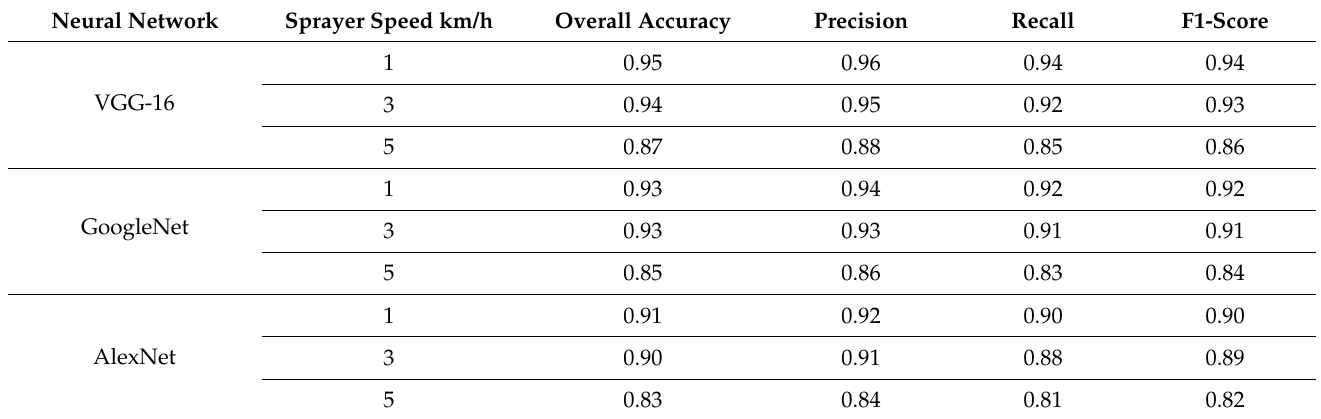
Table 3. CNNs models performance results for weeds classification in real time Lab experiment. Neural Network Sprayer Speed